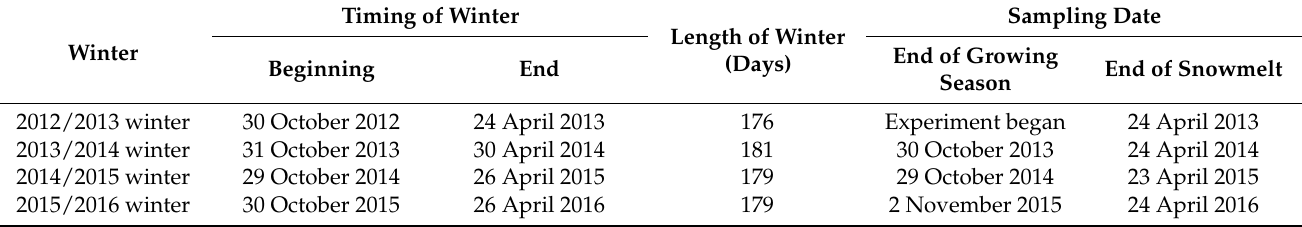
Table 1. Sampling compared with the timings and lengths of winters during the four years of